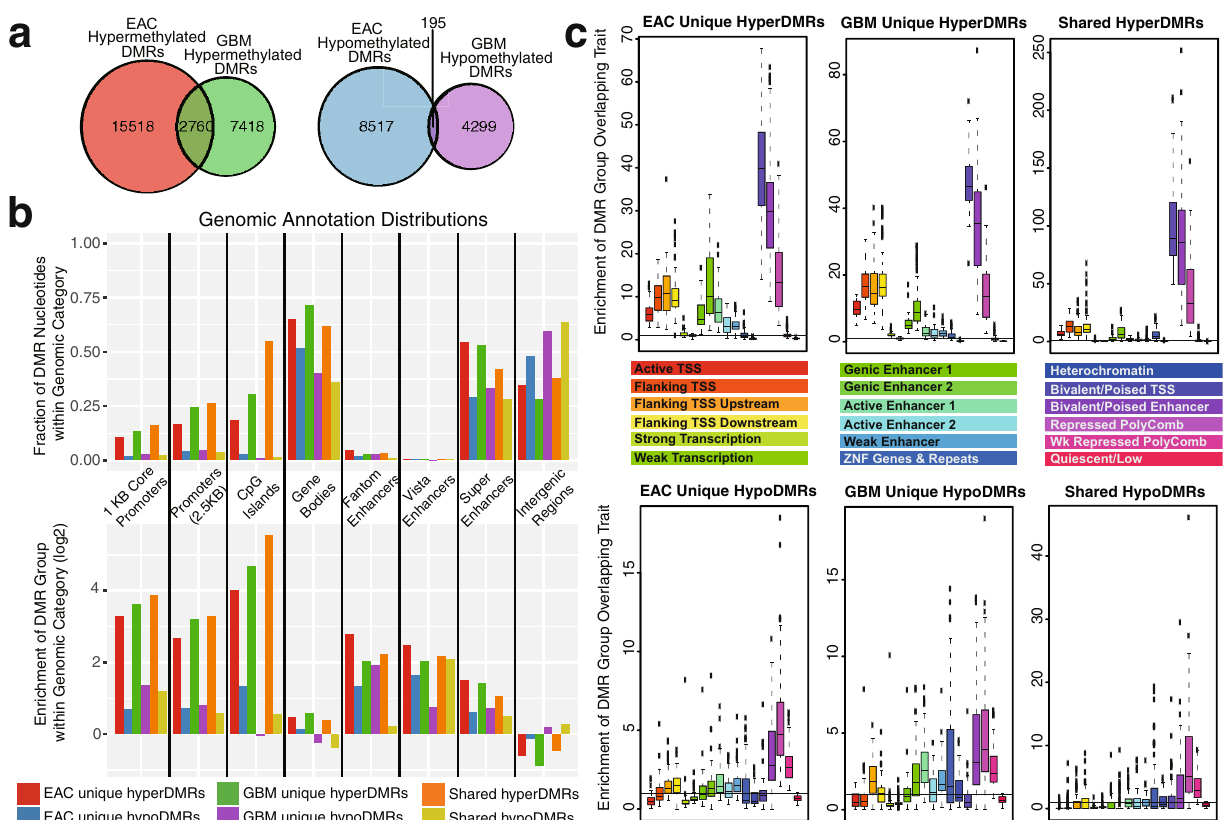
Fig. 1 Comparative analysis of EAC and GBM DNA methylation abnormalities. a Overlap of 500 bp differentially methylated regions (DMRs) in EAC and GBM. Left: hypermethylated DMRs; right: hypomethylated DMRs. Both overlaps are signi fi cant ( p < 2.2E − 308 and p < 6.0E − 199, respectively, hypergeometric tests). b Genomic annotation distribution of EAC and GBM DMRs. Top: percentage of DMR group nucleotides within each